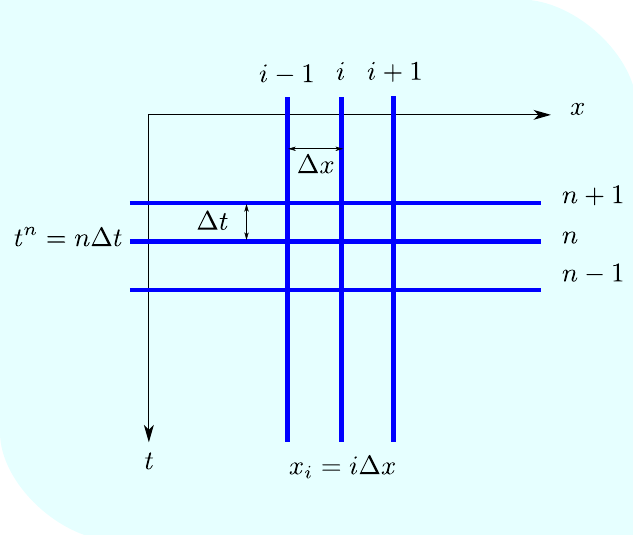
Figure 2. Discretization of time and space in the adjoint